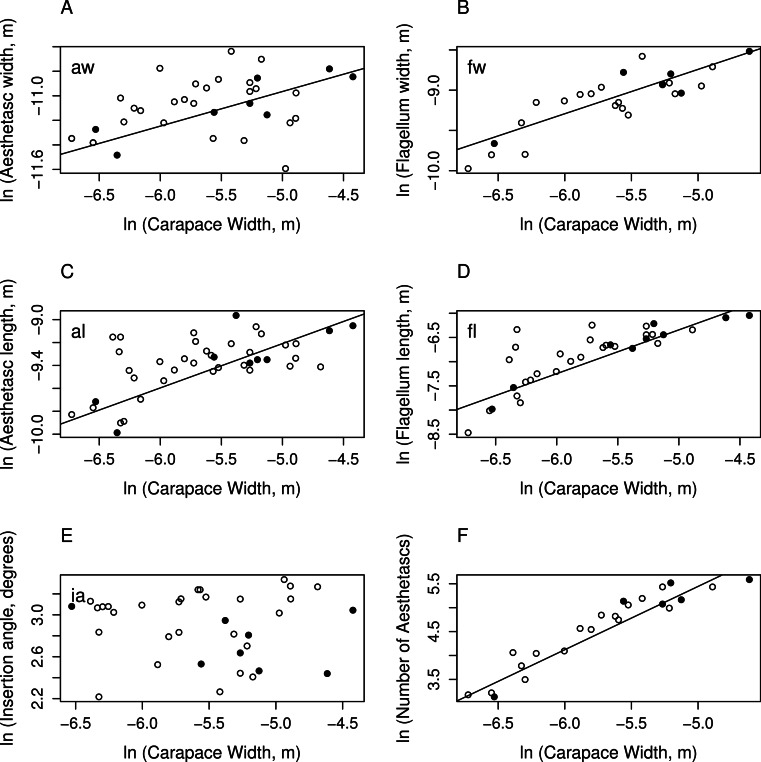
Morphological features graphed against carapace width.Natural logarithm of measurements of aesthetasc and flagellum dimensions vs. natural logarithm of carapace width (m). Each measurement corresponds to the dimension illustrated in Fig. 1. Black, filled circles are measurements on C. perlatus; white, unfilled circles are measurements on C. rugosus. Solid lines represent the significant regression lines. (A) Aesthetasc width (m), (B) flagellum width (m), (C) aesthetasc length (m), (D) flagellum length (m), (E) insertion angle (degrees), and (F) number of aesthetascs in array. There are no significant differences between species in morphometric measurements (see Table 1 for p-values).